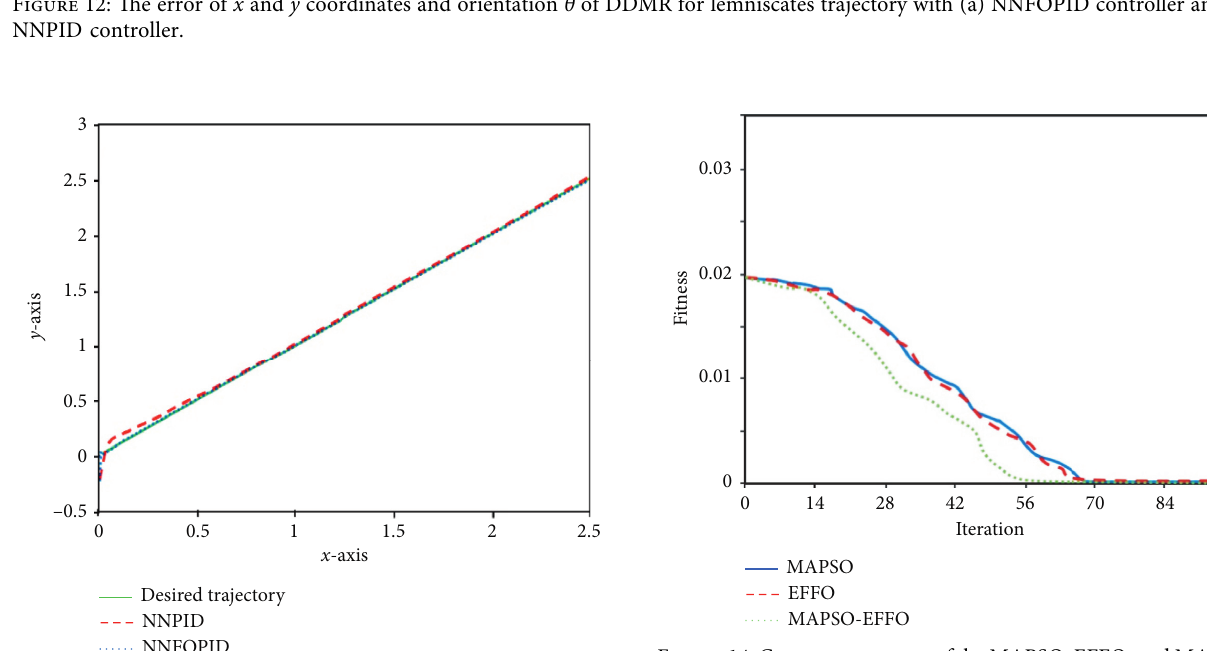
Figure 14: Convergence curve of the MAPSO, EFFO, and MAPSO- EFFO